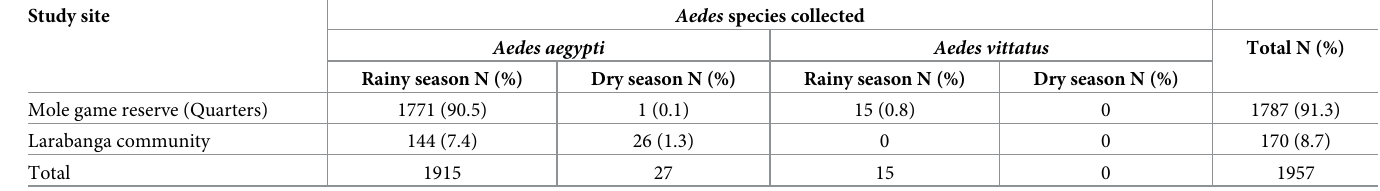
Table 1. Number of Aedes species identified for Mole Game Reserve and Larabanga during the rainy and dry seasons. Study